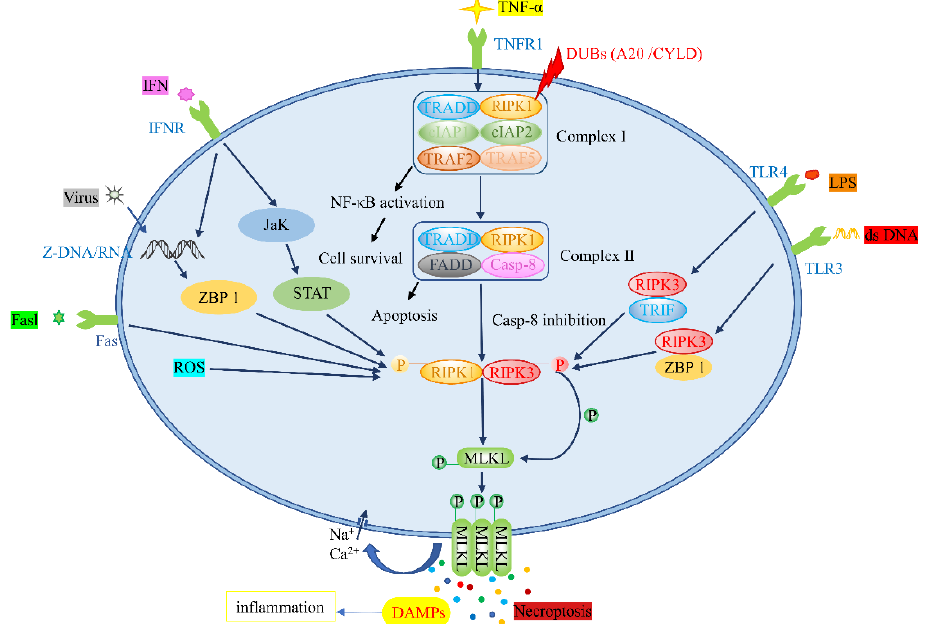
Figure 1. Pathways associated with necroptosis: CYLD: cylindromatosis.